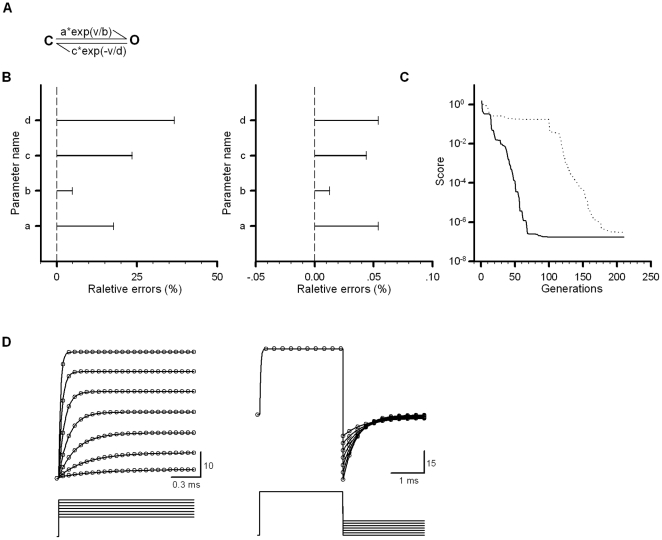
Fit a five-parameter voltage-dependent C-O model to the target current traces.(A) A five-parameter Markov model consisting of a closed state and an open state labeled with the letter C and O, respectively. The forward and backward rate constants separately are a*exp(v/b) and c*exp(−v/d). Here v represents voltage in mV, a and c the pre-exponential factors in ms−1 and b and d the exponential factors in mV. The fifth parameter is the channel number NC. (B) The errors relative to their target values were obtained by estimation of initial values (left) or by fit (right). (C) Convergence of PSO-GSS with (solid line) or without (dotted line) direct estimation. (D) In this model, target parameters a = 1 ms−1, b = 50 mV, c = 1 ms−1 and d = 200 mV; the reversal potential of channels Vr = 0 mV; the single-channel conductance G = 250 pS and the channel count NC = 1. The empty circles represent the target currents at the various voltages shown under each of current traces, and the solid lines represent fitted currents.